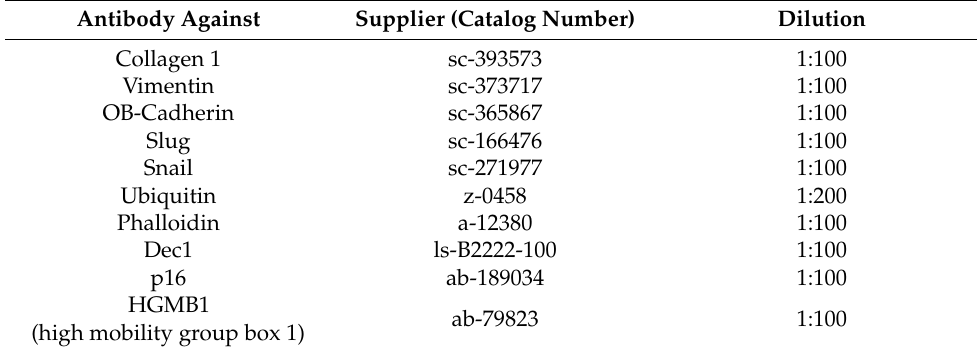
Table 1. Antibodies used in immunohistochemical